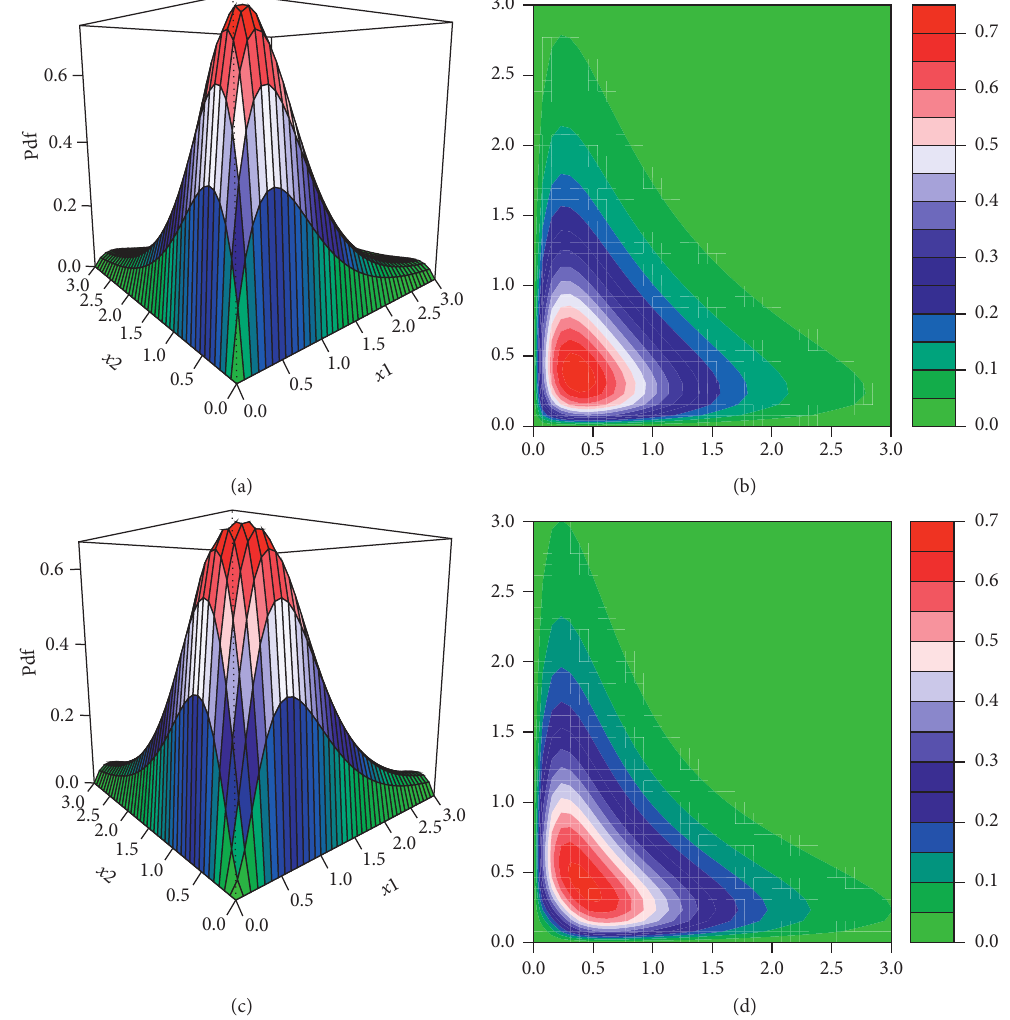
Figure 3: Different plots for the pdf of the FGMBL-Claim distribution for α